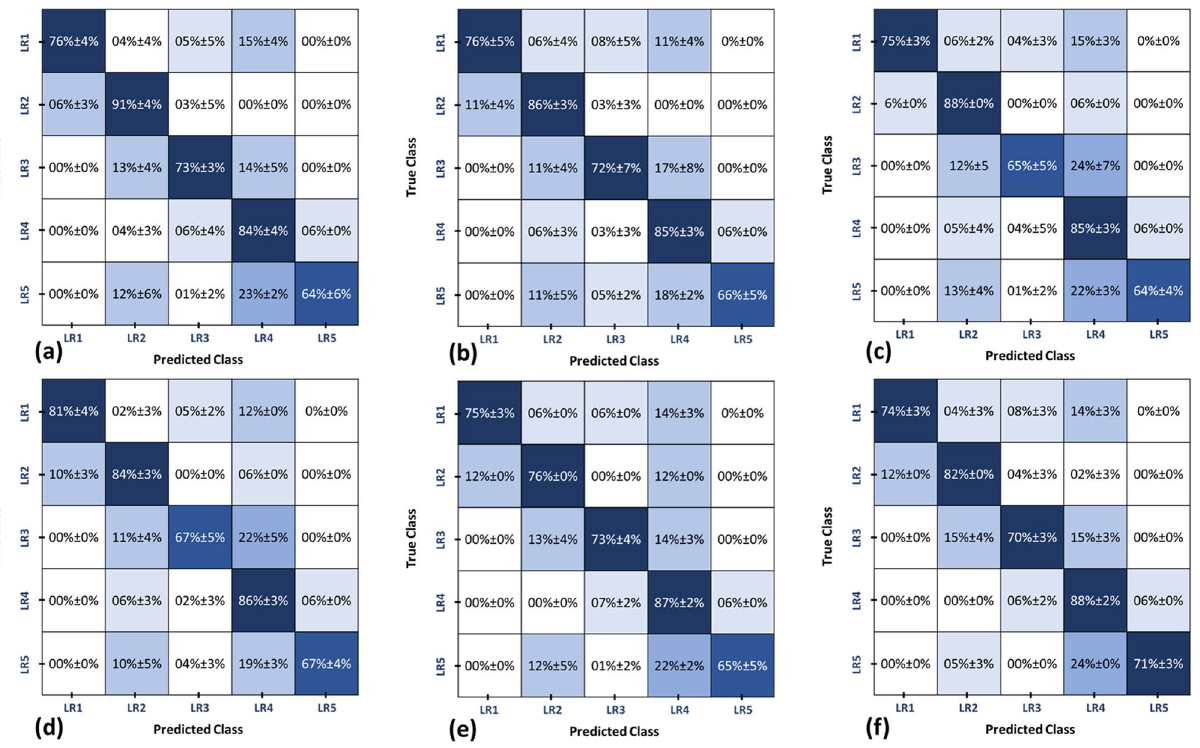
Figure 10. Confusion matrices comparing the final diagnostic performance obtained by using the proposed two-stage RFs classification model along with a LOSO approach for grading the tumors into (LR1, LR2, LR3, LR4, and LR5) after applying six different features/markers reduction techniques as follows: ( a ) wrapper approach based on bi-directional elimination (step-wise selection) using a significance threshold (ST) of